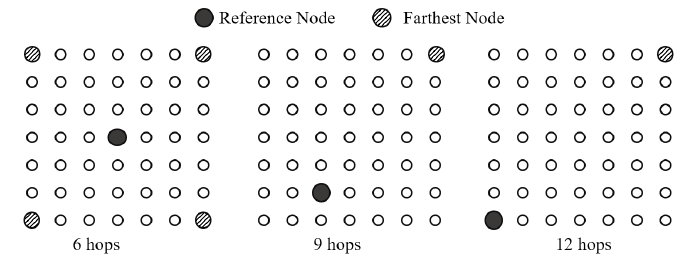
Figure 9. Hop distance between reference node (root) and farthest node in grid